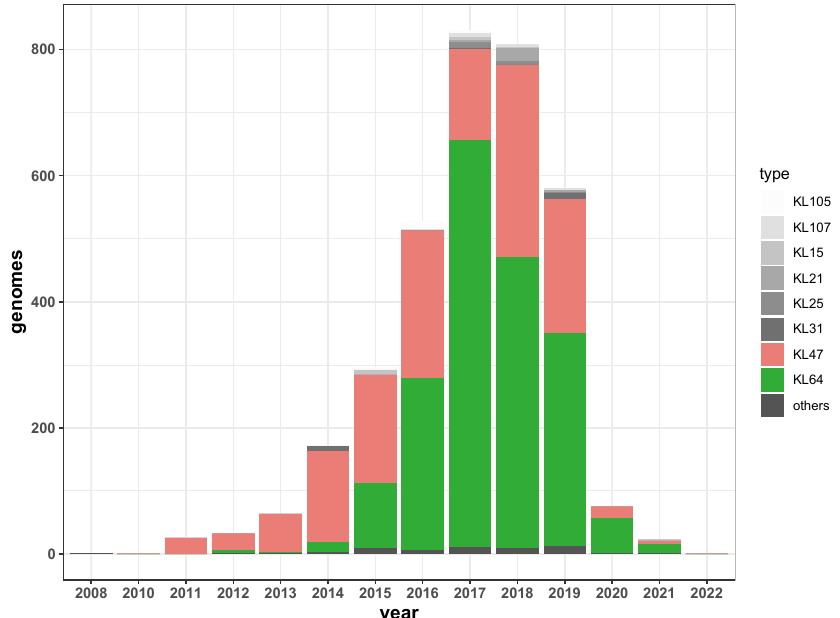
Figure 4. Serotype distribution of ST11 carbapenemase-carrying KPN.